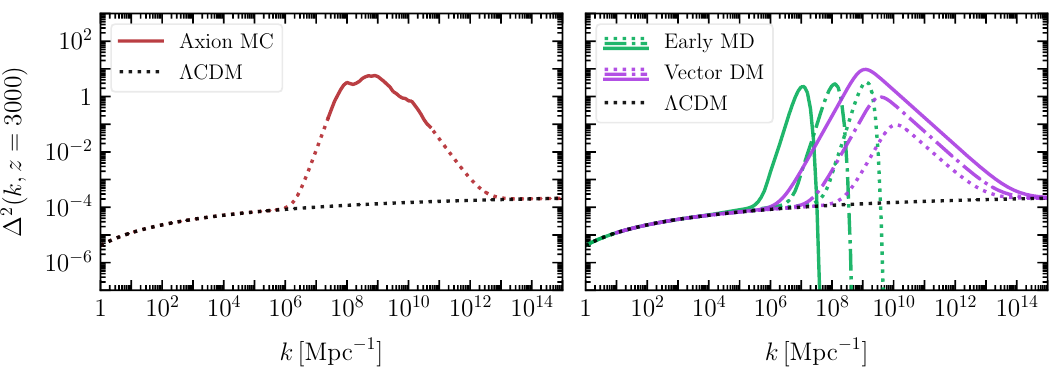
Figure 3 . Left: dimensionless power spectrum at recombination for Λ CDM (black) compared to the post inflationary axion models. Dashed lines indicate regions where, due to lack of numerical or experimental results, the power spectra has been extrapolated. Right: similar to the left panel, except for the vector DM (purple), and early matter domination (orange) models replacing the post inflationary axion. For the early MD model we show the power spectrum obtained with three different choices of the reheating temperature: T = 10 MeV (solid), T = 0 . 1 GeV (dashdot), and RH RH T RH = 1 GeV (dotted). For the vector DM model we fix the inflationary scale at H I = 10 14 GeV and consider three DM masses: m = 10 − 15 GeV (solid), m = 10 − 14 GeV (dashdot), and m = 10 − 13 GeV